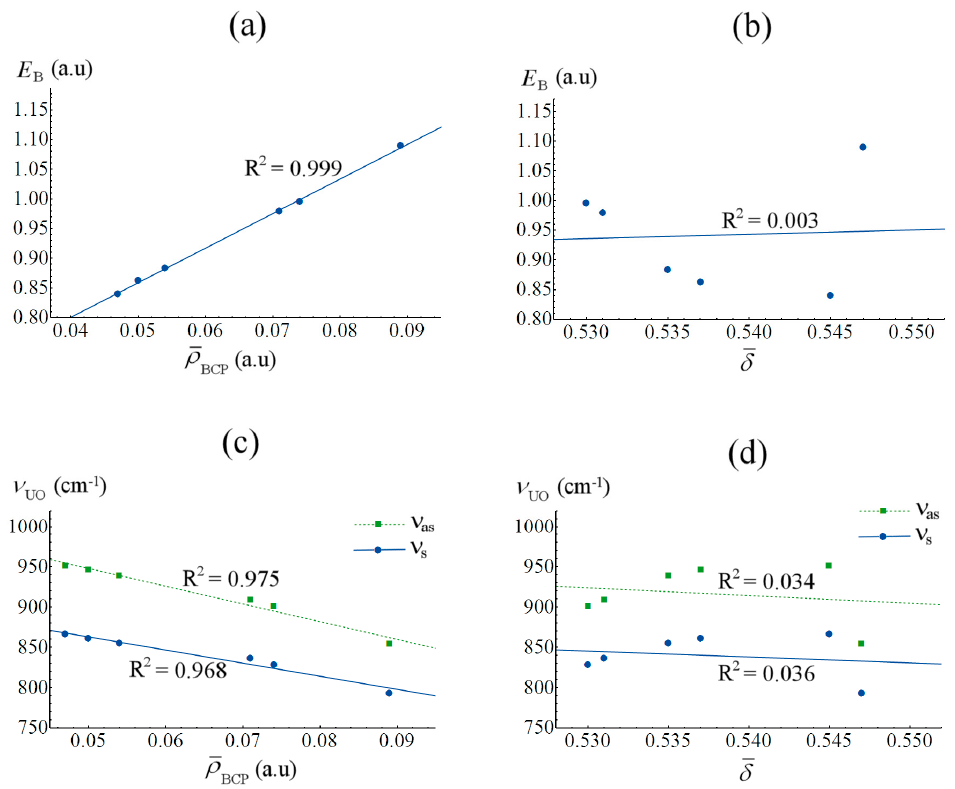
Figure 7. Correlation between QTAIM parameters of the equatorial bonds, the binding energy of the equatorial ligand set, and the U–O stretching vibrational frequencies in [UO 2 X 2 Y 2 ] 2 − complexes. ( a ) correlates E B and ρ , ( b ) correlates E B and δ , ( c ) correlates ν UO and ρ , ( d ) correlates ν UO and δ .